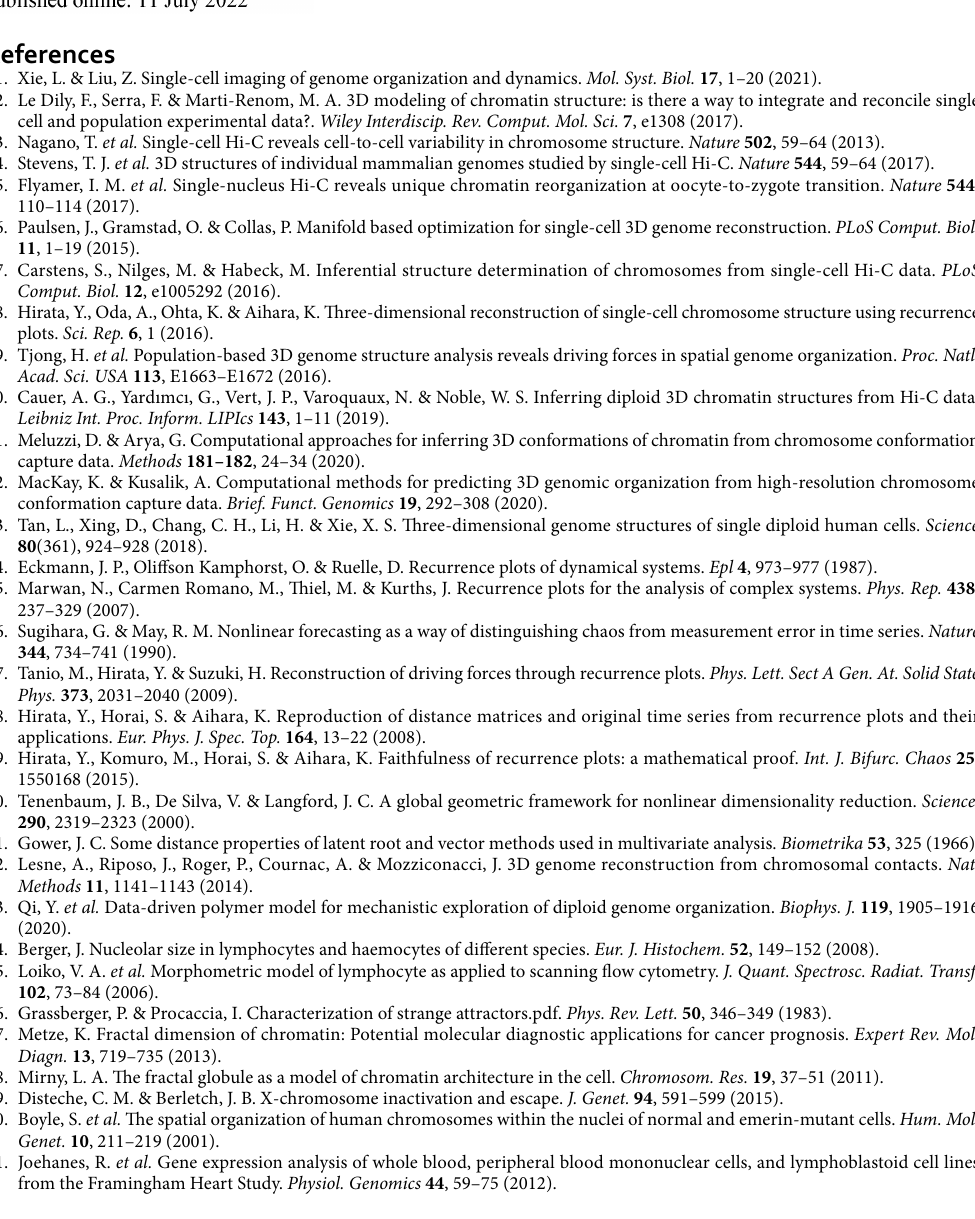
Figure 4. Comparisons of the reconstructed structures by radial distances for each allele at a 40-kb resolution. Panels ( a ) and ( b ) show boxplots of the radial distribution distributions for the corresponding alleles for GM cells and PBMC cells, respectively. For each chromosome, from left to right is our maternal allele, our paternal allele, the maternal allele from Ref. 13 , and the paternal allele from Ref. 13 , except for the sex chromosomes for PBMC cell in panel ( b ), where the left is our reconstructions and right is those of Ref. 13 . Here, GM cells 01 and 04 are excluded because they have some chromosomes without contact information. Panel ( c ) shows the scatterplot of the mean radial distance over all valid cells of our GM cell reconstructions versus the FISH results in Boyle et al . (2001). Here, we also plotted GM cell reconstructions by Tan et al. (2018) versus the FISH results. Panel ( d ) highlights the differences in the radial distances between PBMC cells and GM cells in the top five genes differentially expressed in PBMC cells 31 . According to Ref. 31 , the top five differentially expressed genes are located on chromosomes 7, 3, 15, 4, and